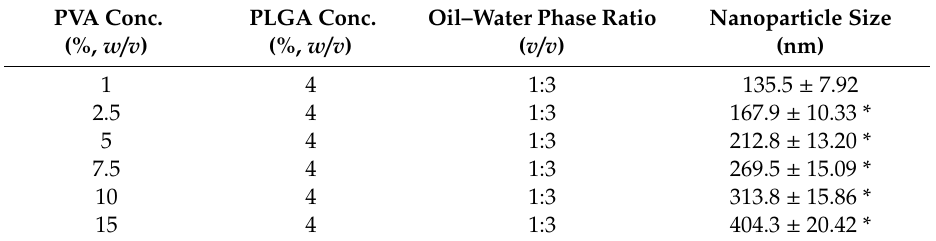
Table 2. E ff ect of poly vinyl alcohol (PVA) concentration on mean particle size ( n = 5, mean ± SD). PVA Conc. PLGA